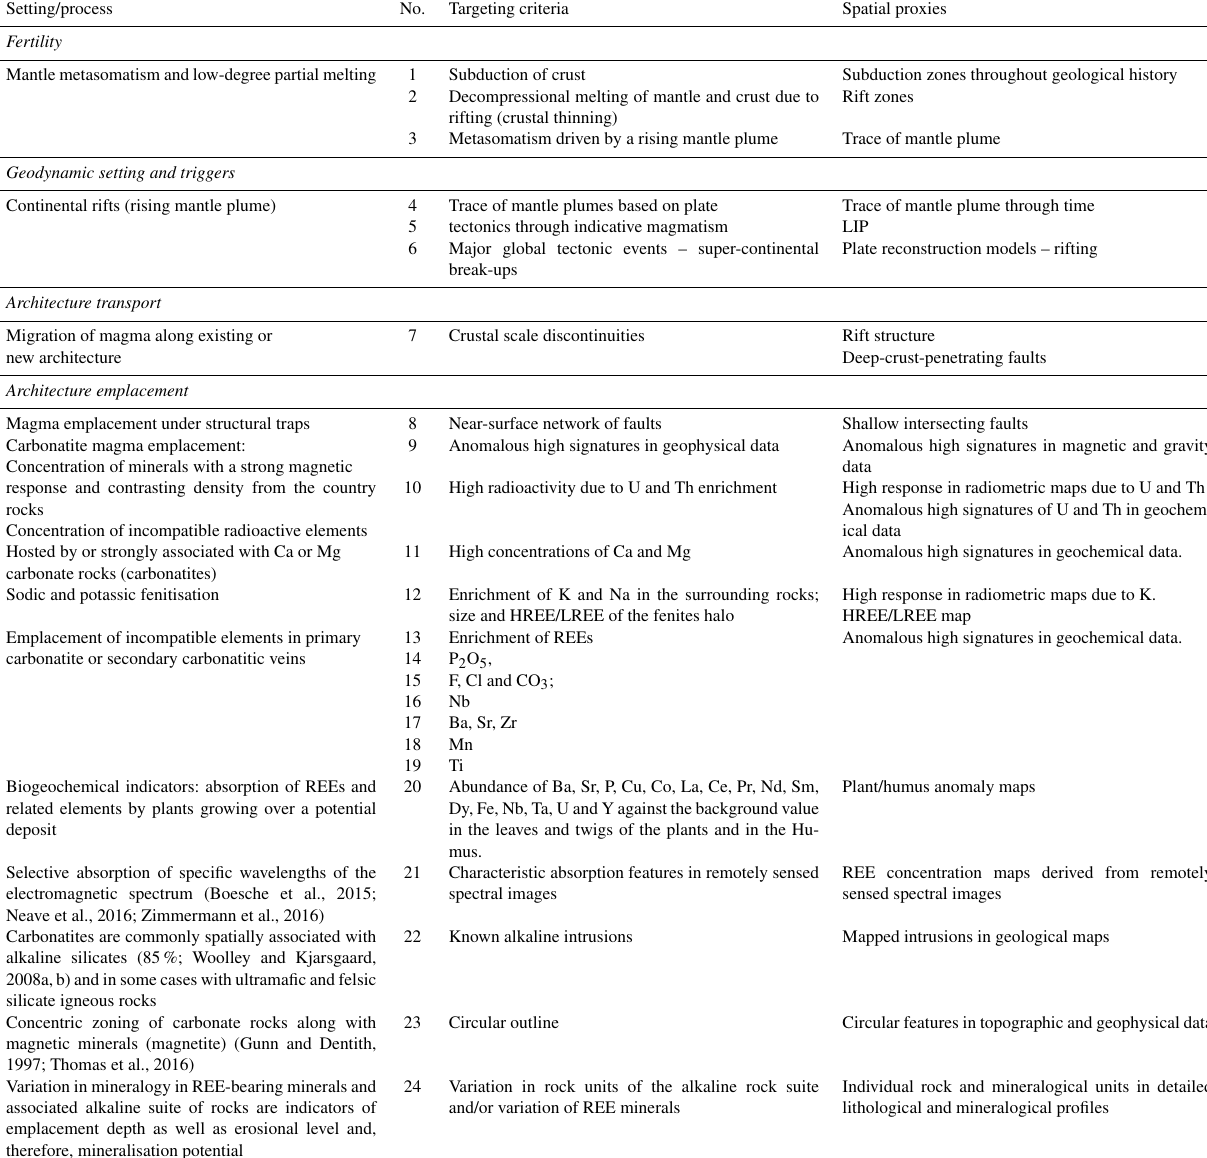
Table 2. Conceptual REE mineral systems model (adapted from Aranha et al., under review). The index numbers correlate to the numbers in blue in Fig.